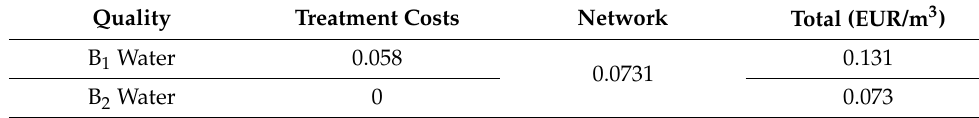
Table 4. Cost of the tertiary treatment and distribution networks (EUR/m 3 ).